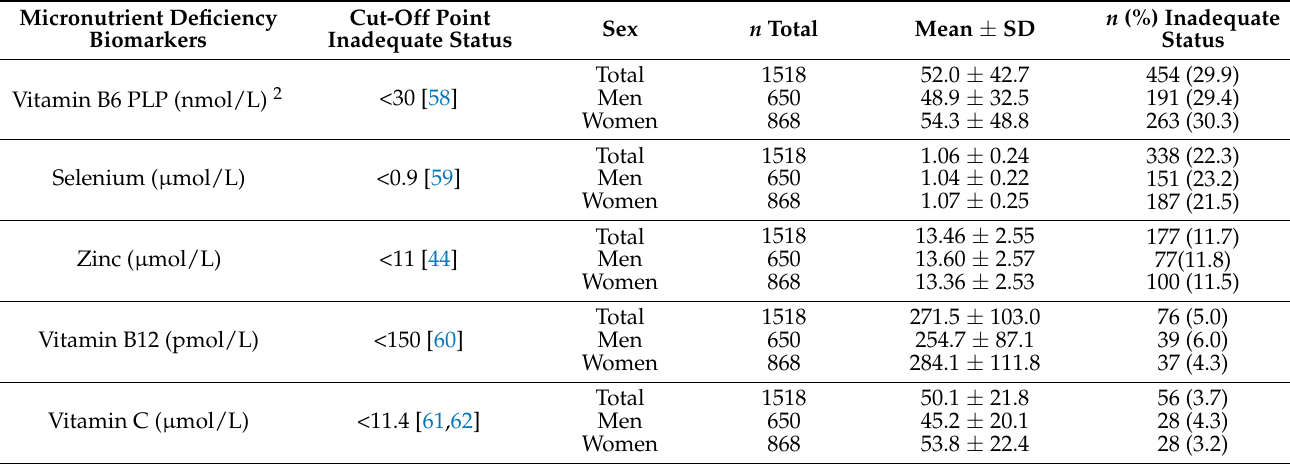
Table 2. Descriptives of the micronutrient deficiency biomarkers selected to define a poor nutritional status 1 . Micronutrient Deficiency